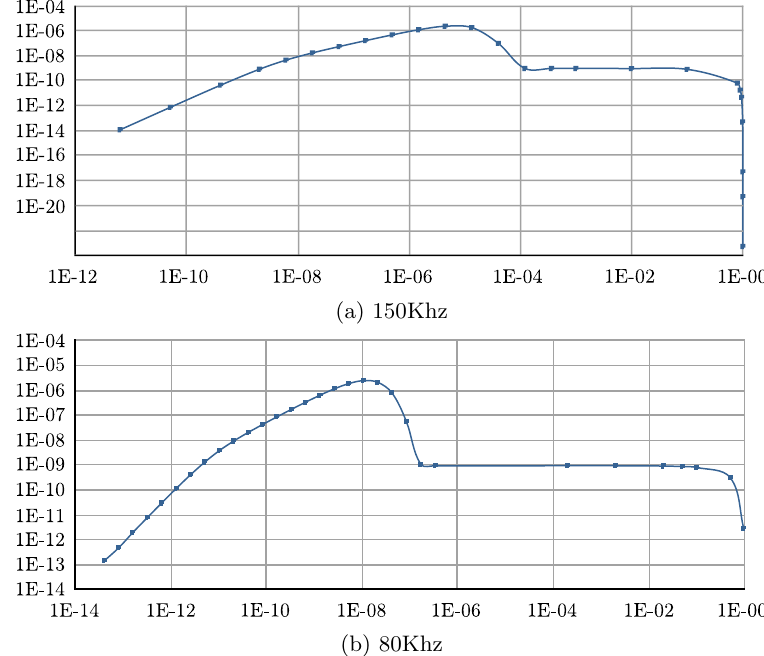
Figure 4: The value of for the function P ( N ) when the values of f and p